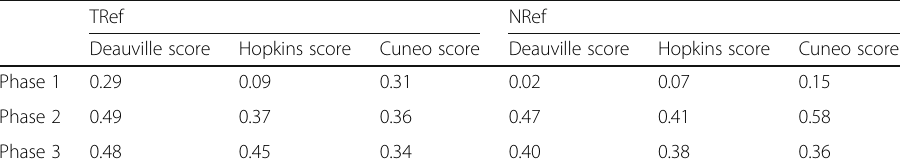
Table 3 Krippendorff ’ s alpha values for inter-observer agreement throughout 3 rounds of revision of post-treatment FDG-PET/CT scans for Tref (defined as the area with highest FDG uptake within the residual primary tumor) and Nref (defined as the residual lymph node with highest FDG uptake) TRef